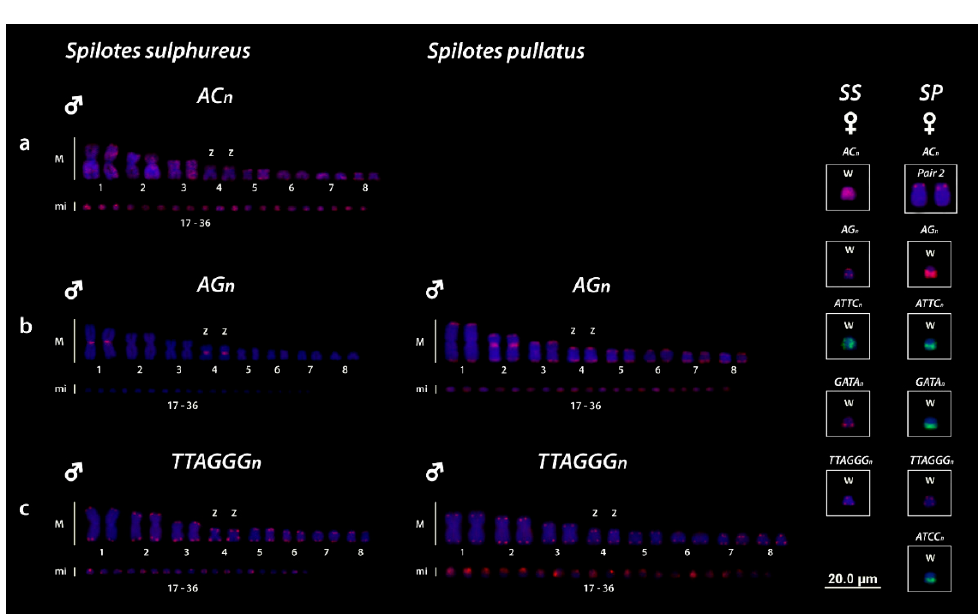
Figure 2. Mapping of (AC)n ( a ), (AG)n ( b ) and (TTAGGG)n ( c ) on the chromosomes of S. sulphureus and S. pullatus . AC n repeats were evidenced on the second pair of both species and on both Z and W chromosomes of SS but absent in the Z and W chromosomes of SP (a and highlighted in the boxes). Highlighted in the boxes are the differential accumulation of SSR repeats on the W sex chromosomes for SS ( S. sulphureus ) and SP ( S. pullatus ).